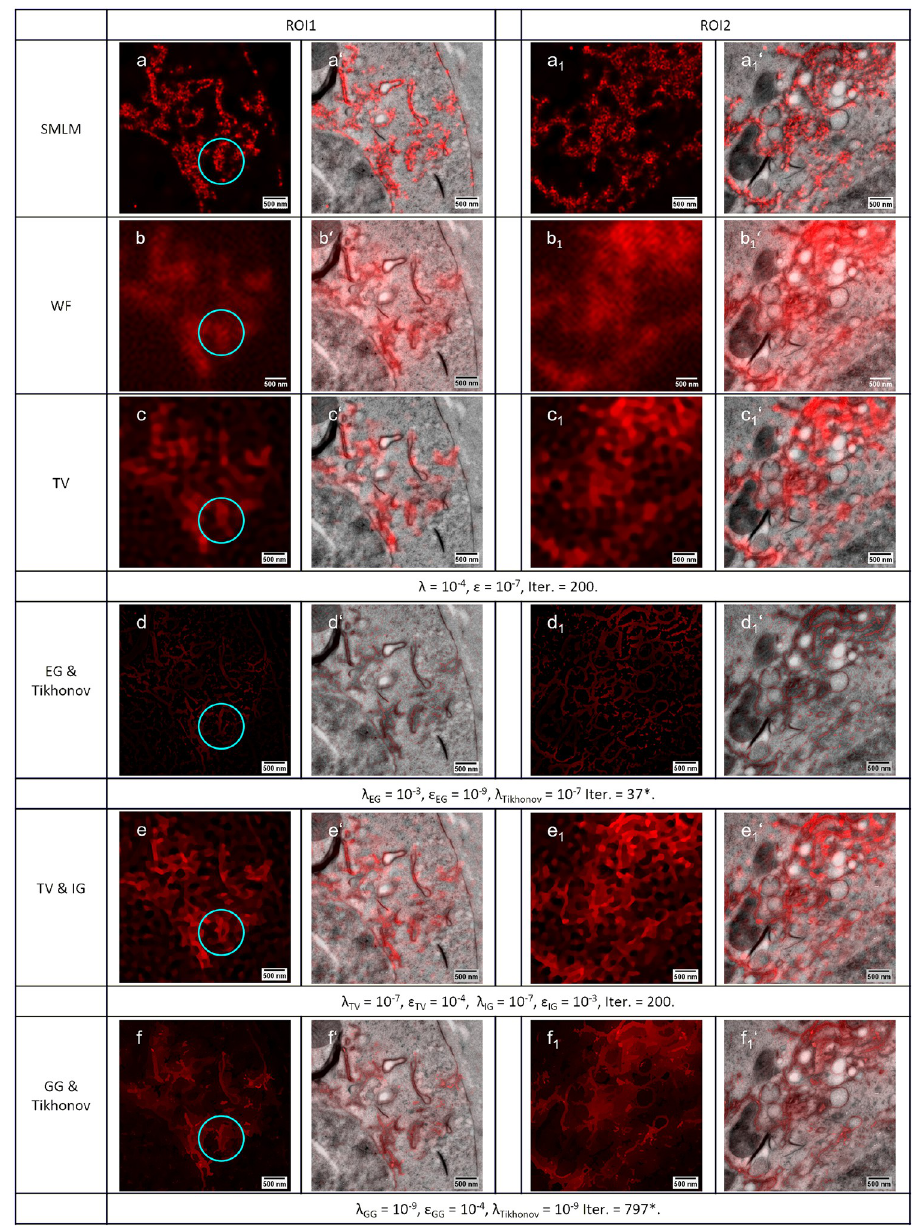
Fig 6. Restored images of ROI1 and ROI2. a)—a 1 ’) The restored images of single-molecule localization microscopy. b)—b 1 ’) The wide field LM image is used for the all deconvolutions of this figure. c)—c 1 ’) The results of modified total variation deconvolution without guidance. d)—d 1 ’) The results of EG & Tikhonov deconvolution. e)—e 1 ’) The results of the combined TV & IG deconvolution. f)—f 1 ’) The restored images of GG & Tikhonov deconvolution. The results of the EM-guided deconvolution shows more information than the regular LM deconvolution. Their results